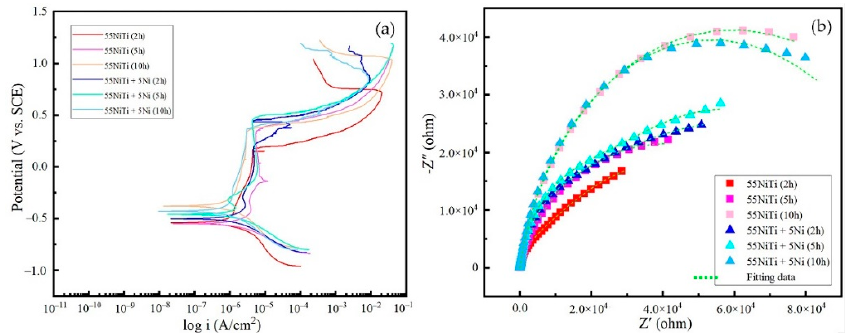
Figure 20. Electrochemical behavior of the coatings under 2, 5 and 10 h immersion in a 3.5 wt.% NaCl solution: ( a ) PD polarization results; ( b ) Nyquist plots from EIS results. solution: ( a ) PD polarization results; ( b ) Nyquist plots from EIS